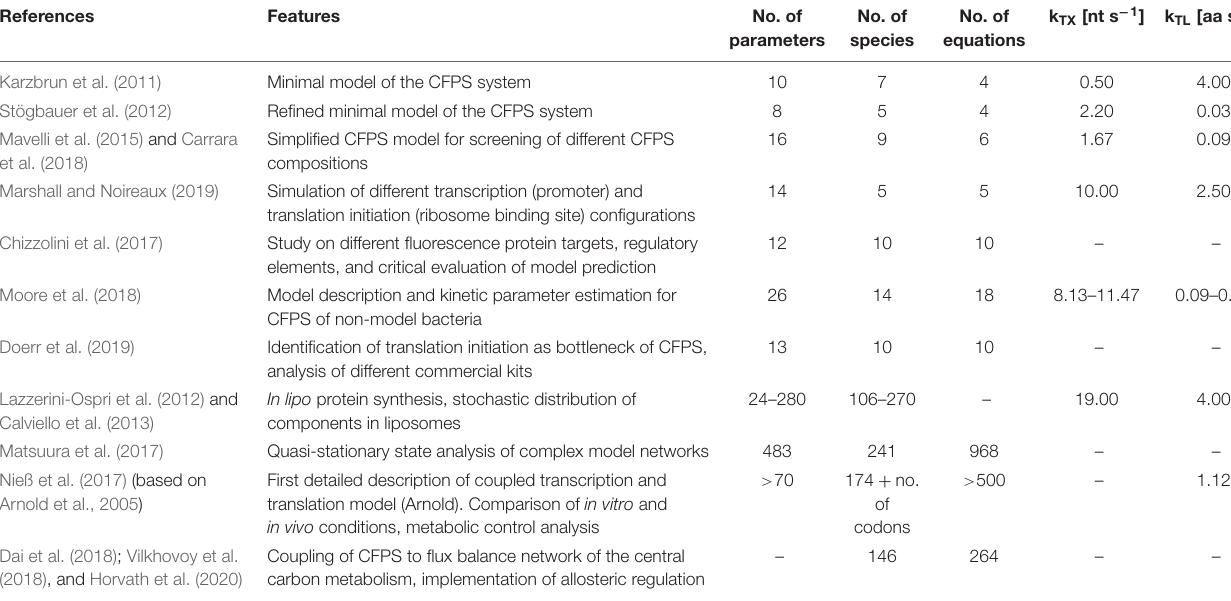
TABLE 1 | Overview of the different granularities of CFPS